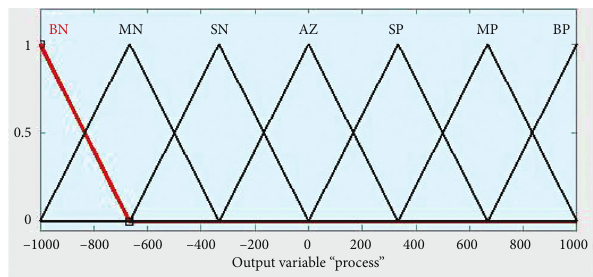
Figure 6: Output membership function for the